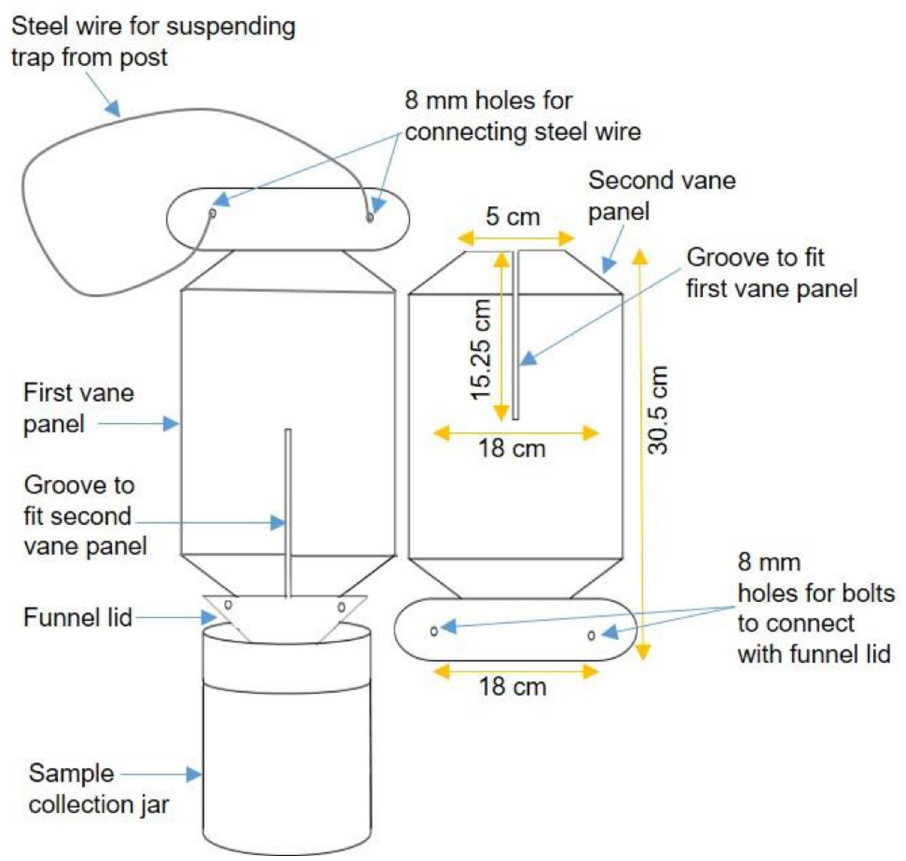
Figure 1. Design of trap used for sampling of wild bees in livestock pasture system. Design and illustration by N. Joshi. Specific information related to trap parts and color is given in the methods